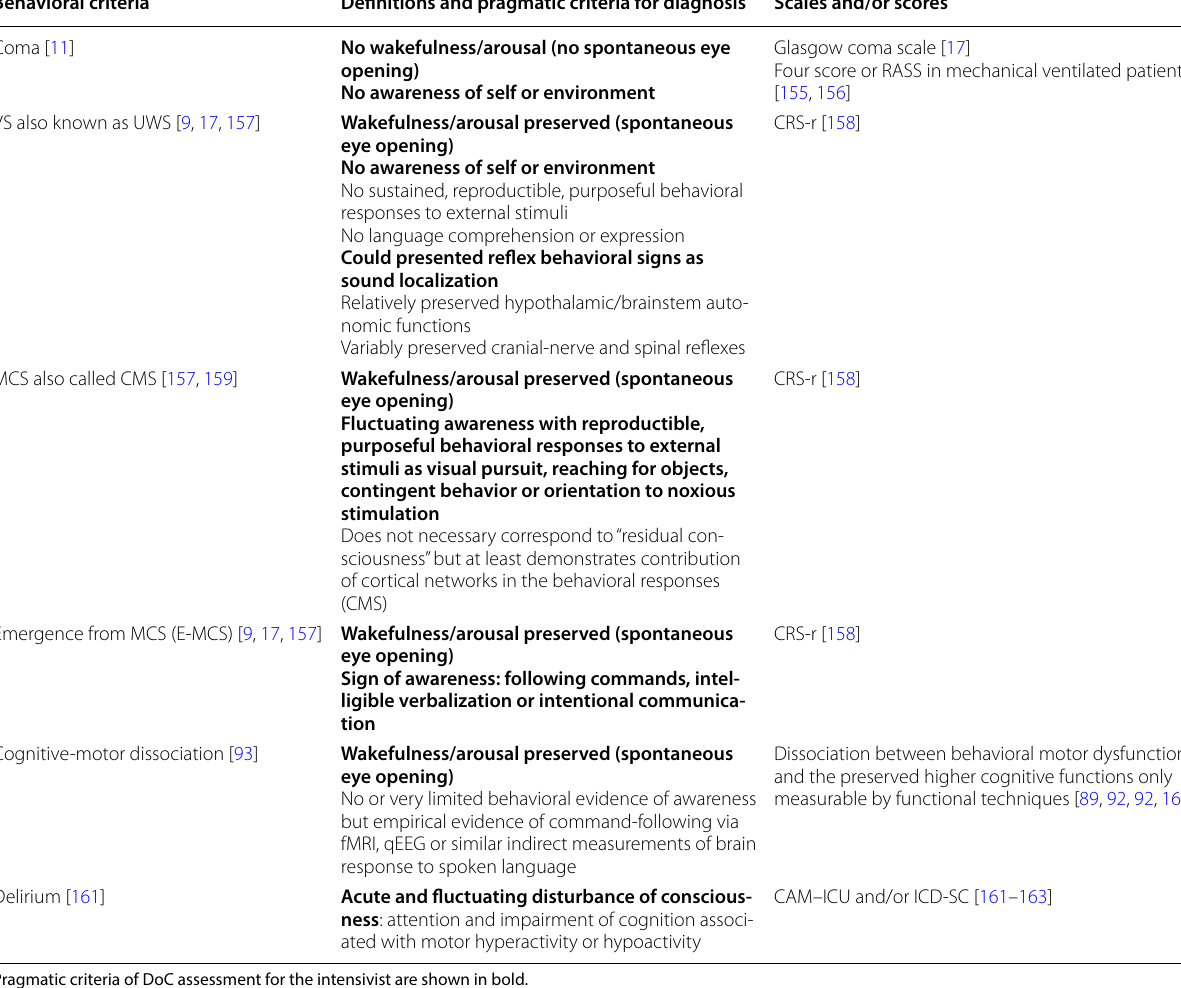
Pragmatic criteria of DoC assessment for the intensivist are shown in